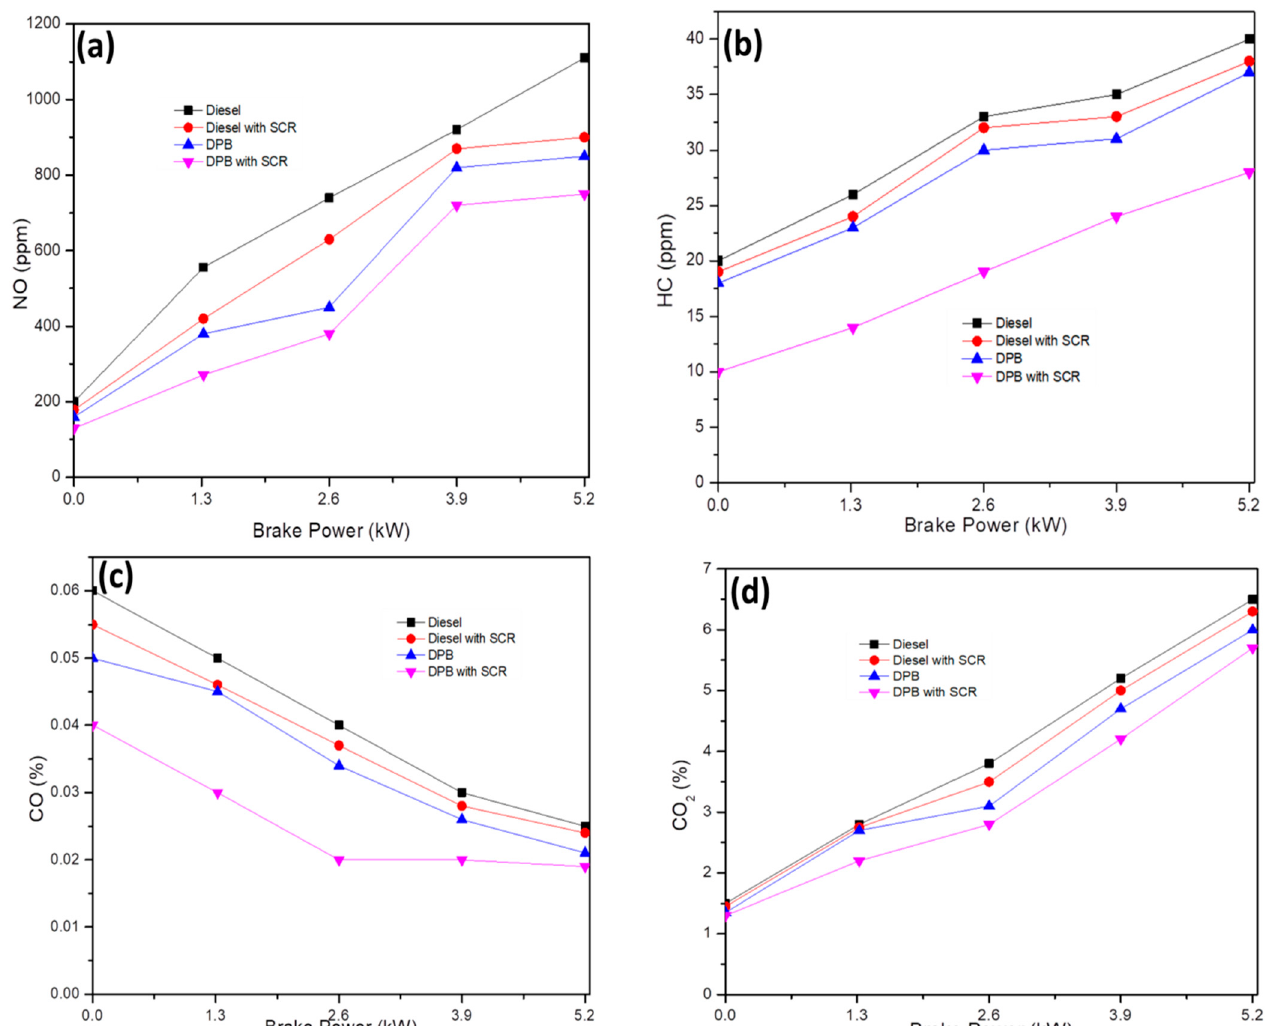
Figure 7. Dependence of NO x ( a ), HC ( b ), CO ( c ), and CO 2 ( d ) emissions from the SCR-coated ex- haust under different engine loads. exhaust under different engine